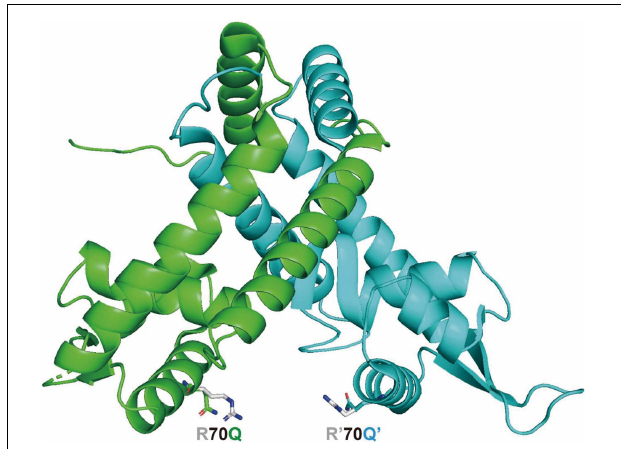
FIGURE 4 | Model structure of MexR R70Q protein in the open (able to bind DNA) form, based on the “Crystal structure of the MexR repressor of the mexRAB-oprM multidrug efflux operon of Pseudomonas aeruginosa ” (Lim et al., 2002) (PDB entry 1LNW), side chain of the mutant residue was generated by